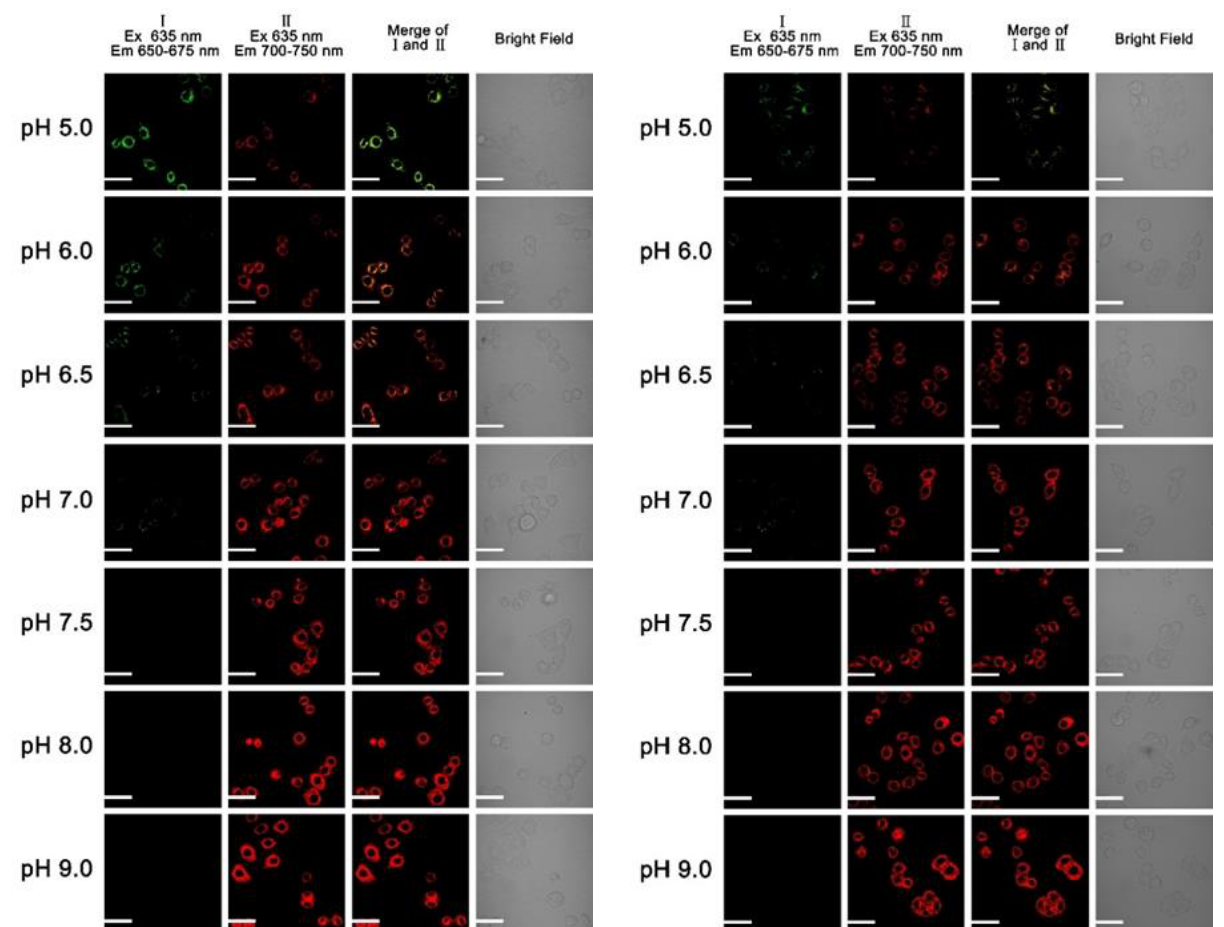
Figure 16. Fluorescence images of HeLa cells incubated with 10 µ M probes AH + ( left ) and BH + ( right ) and nigericin to homogenize the intracellular pH of the cells with the surrounding medium at different pH values from 9.0, 8.0, 7.5, 6.5, 6.0, to 5.0. The first and second channels in the fluorescence images were recorded from 650 nm to 675 nm, and from 700 nm to 750 nm under excitation at 635 nm, respectively. HeLa cells were incubated with 10 µM probe AH + or BH + for 20 min first, and then treated with 5 µg/mL nigericin in different pH buffer solutions at 37 °C for 20 min. Live cell images were obtained by an Olympus IX 81 confocal microscope.